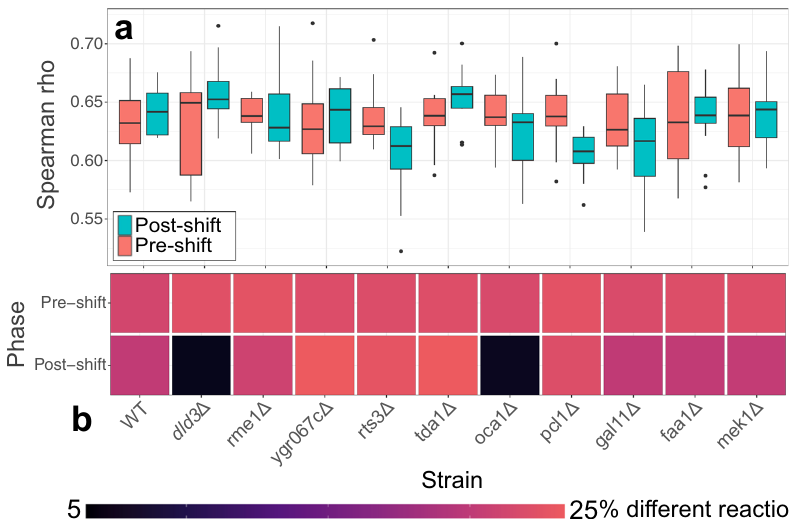
Fig. 4 Analysis of reaction fl ux reroutes in M1 and M1Smart. a Distribution of Spearman correlations of pairwise comparisons between M1 and M1Smart simulations for knockout-strains and growth-phases. b Fraction of reactions signi fi cantly changed between simulations by models M1 and M1Smart ( p -value < 0.1, Wilcoxon signed rank test). In the boxplots in a , the center lines represent the median; box limits represent upper and lower quartiles; whiskers extend to the fi rst or last data point that is within 1.5× the interquartile range of the box limits in the lower and upper directions respectively. Dots are values outside of 1.5× interquartile range beyond either end of the box. Table 2. Model evaluation.